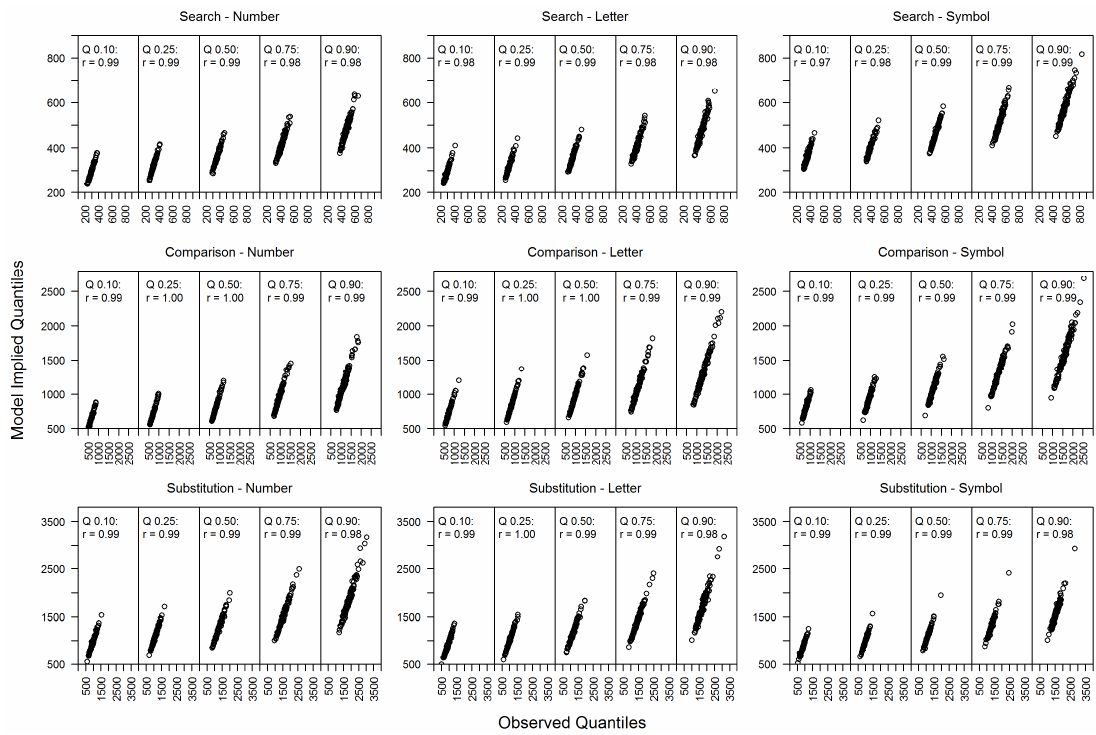
Figure A1. Scatterplots and correlations across participants of model implied and observed RTs for five quantiles (0.10, 0.25, 0.50, 0.75, and 0.90) of the RT distribution.